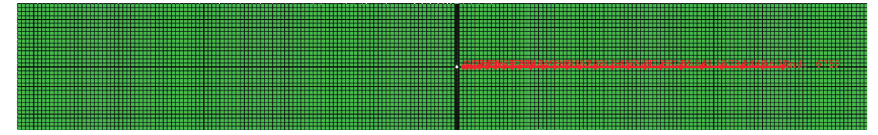
Figure 7: Pick path for the strain of CFRP laminated